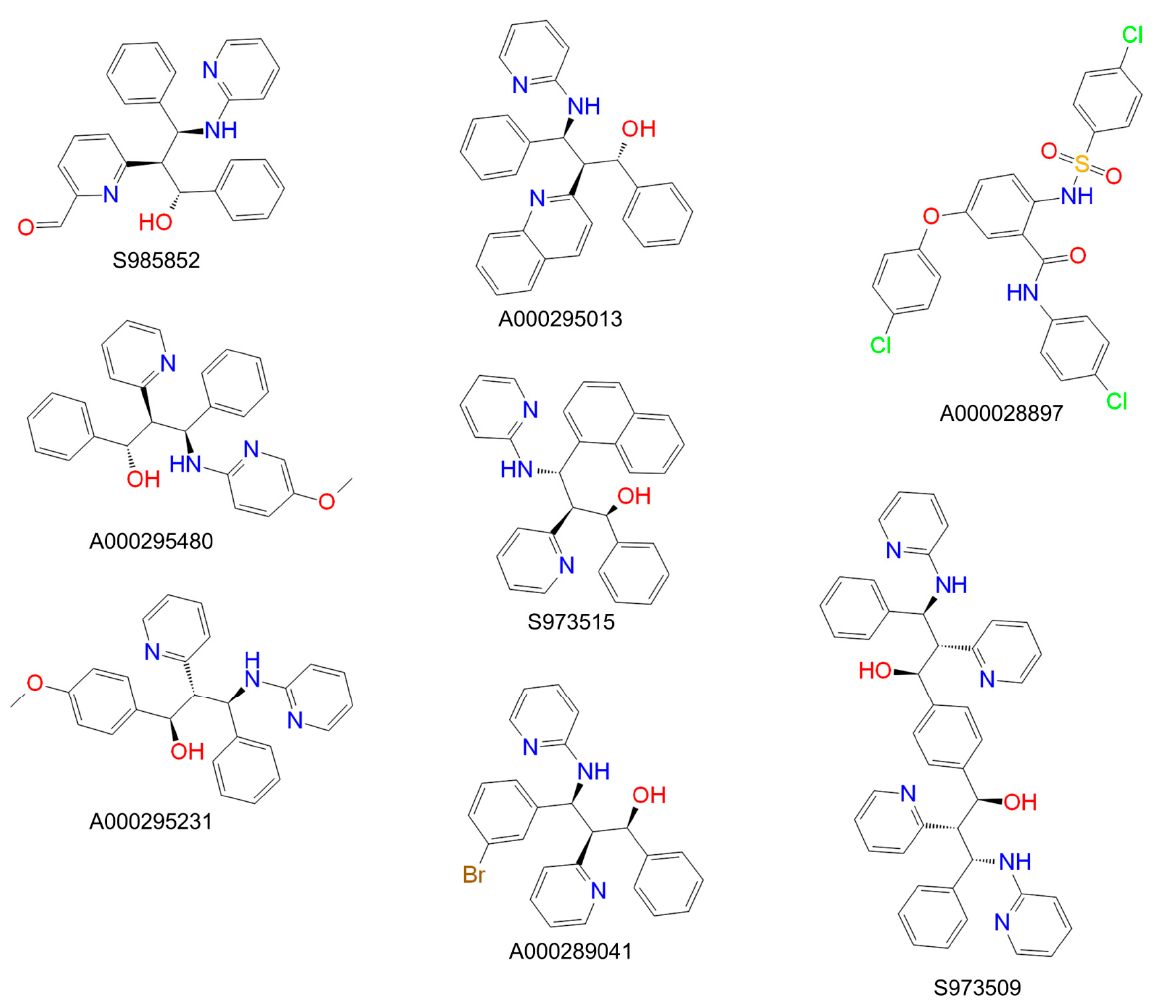
Figure 2. Structures of the eight most potent propanolamine [ 3 H]preS1 lipopeptide binding inhibitors (see Figure 1).